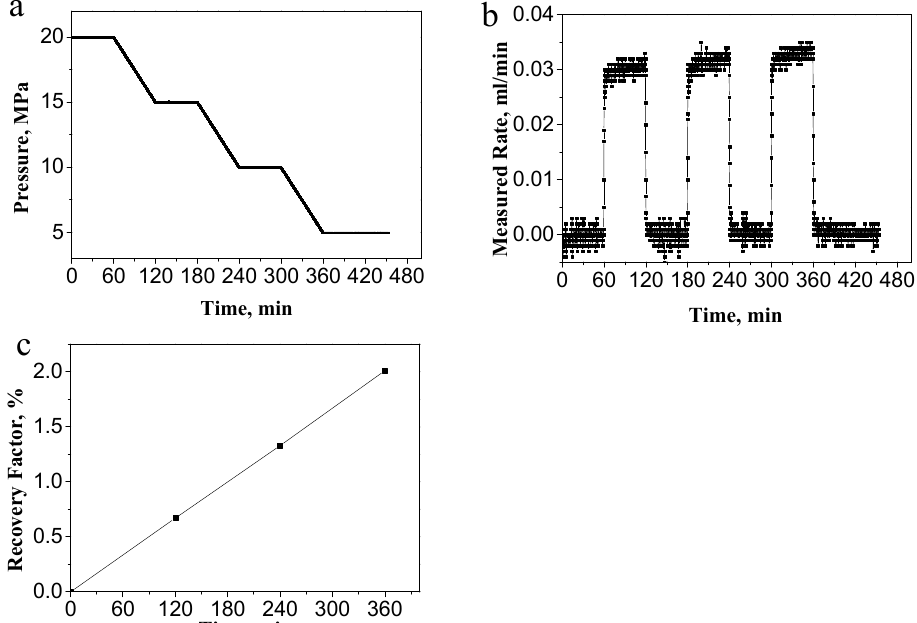
Figure 5. Pressure, production rate and oil recovery of the step-like pressure depletion experiment. ( a ) Pressure change with time; ( b ) Oil production rate change with time; ( c ) Oil recovery factor change with time.